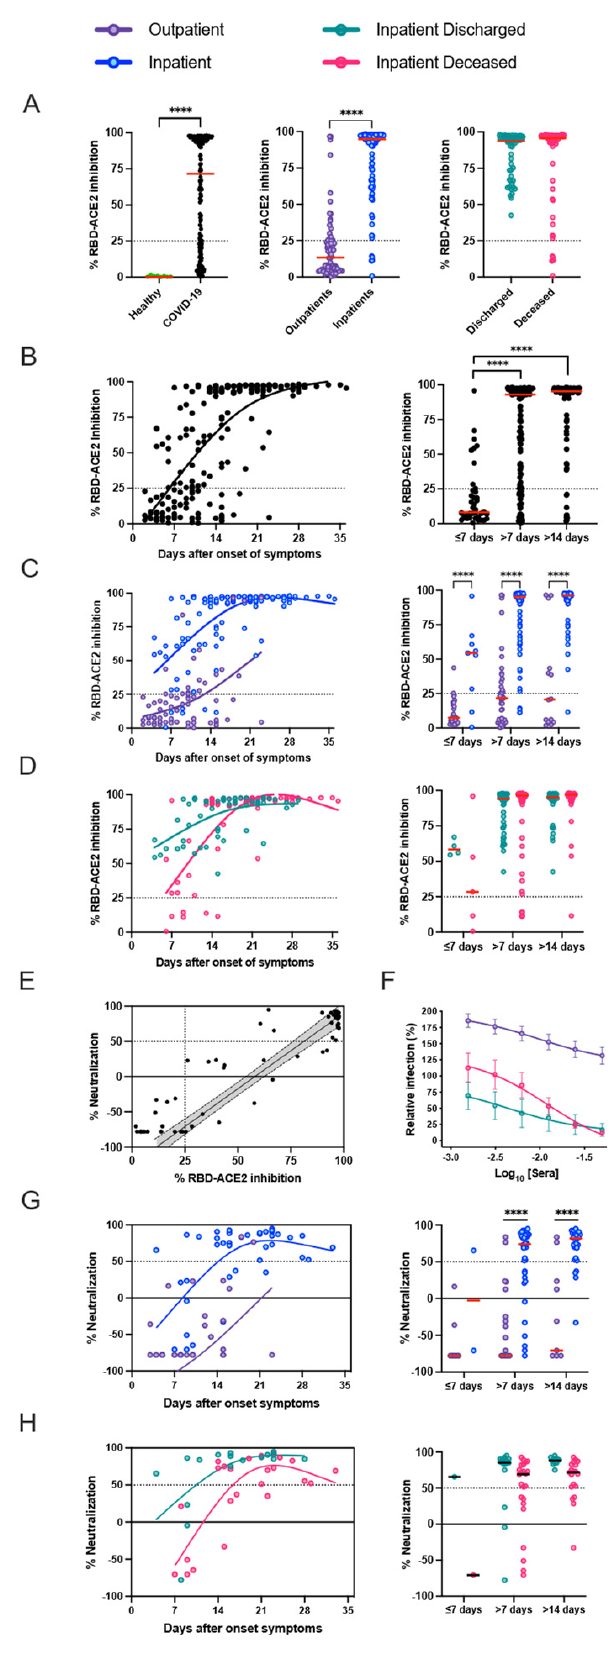
Figure 3. RBD-ACE2 interactions blocking antibodies and neutralizing antibody increase with symptomatic days and correlates with disease severity. ( A ) Commercial RBD-ACE2